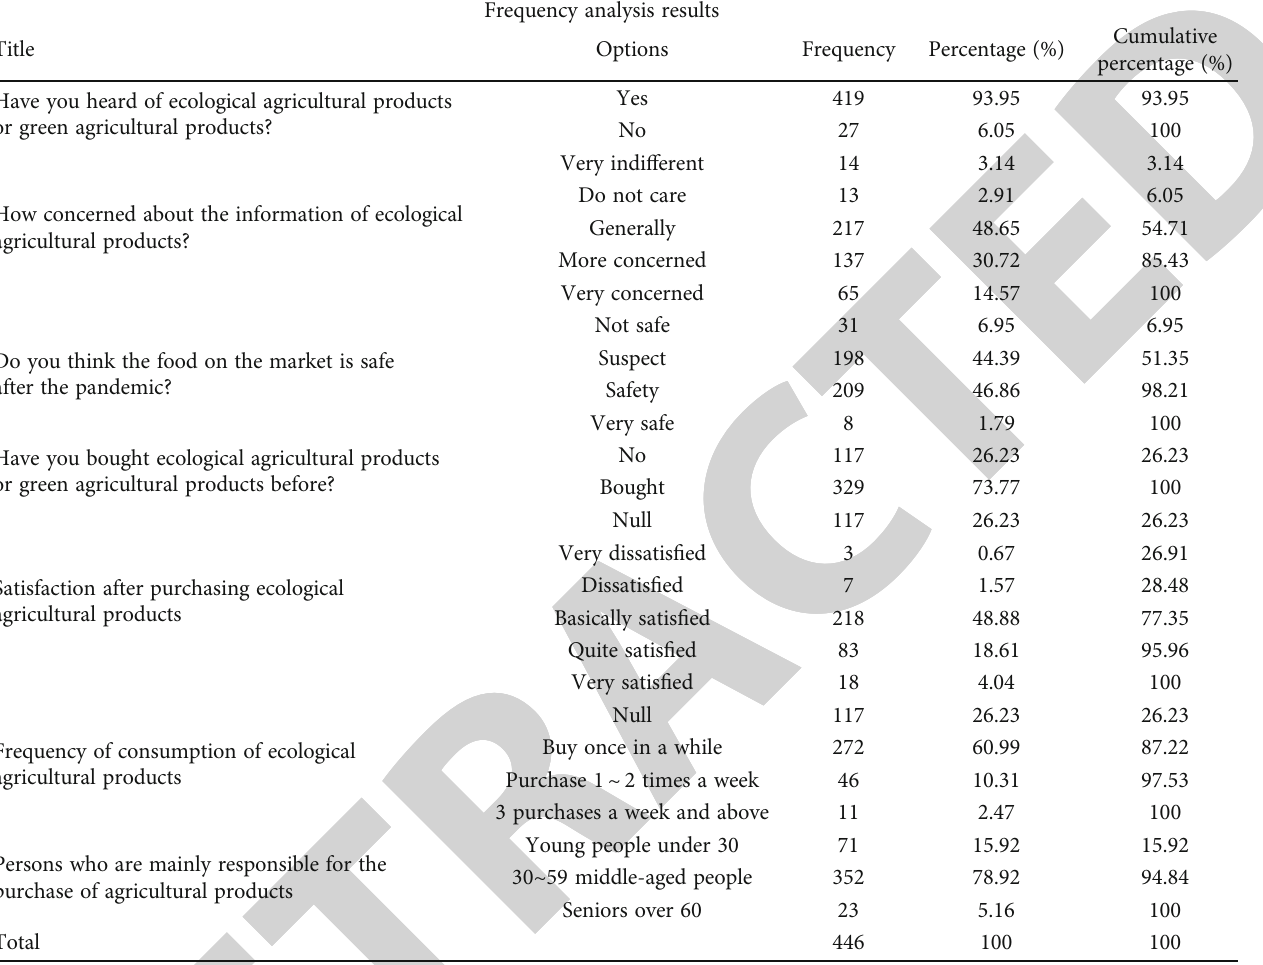
Table 3: Consumer Ecological